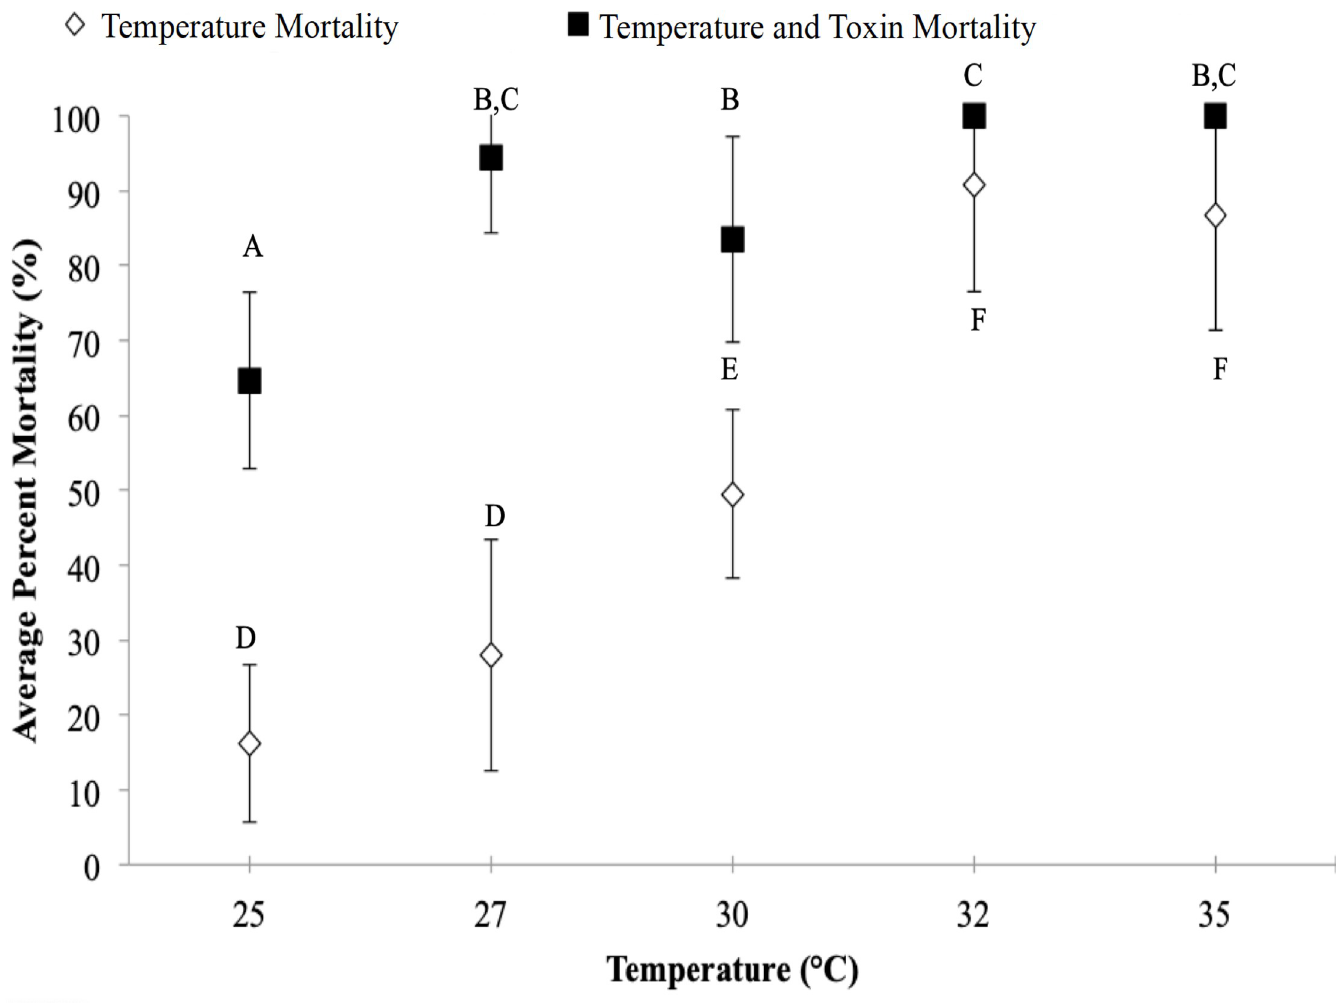
Fig 3. Temperature and microcystin-LR exposure from 25˚C-35˚C. Average percent mortality of B . longirostris collected in June 2016 over a range of temperatures when exposed to the LC 50 of 26.3 μ g L -1 microcystin-LR for 48-hrs. Temperature control treatments did not contain microcystin-LR. Error bars represent standard deviation. N = 9. Different letters indicate significant difference (p-value < 0.05, Fisher’s LSD). ANCOVA: p < 0.0001. R 2 = 0.80. F ANOVA: R 2 = 0.84. p -value < 0.0001. F 4 , 30 = 40.23. Temperature plus Toxin one-way ANOVA: R 2 = 0.68. p -value < 0.0001. F 4 , 30 = 15.92.